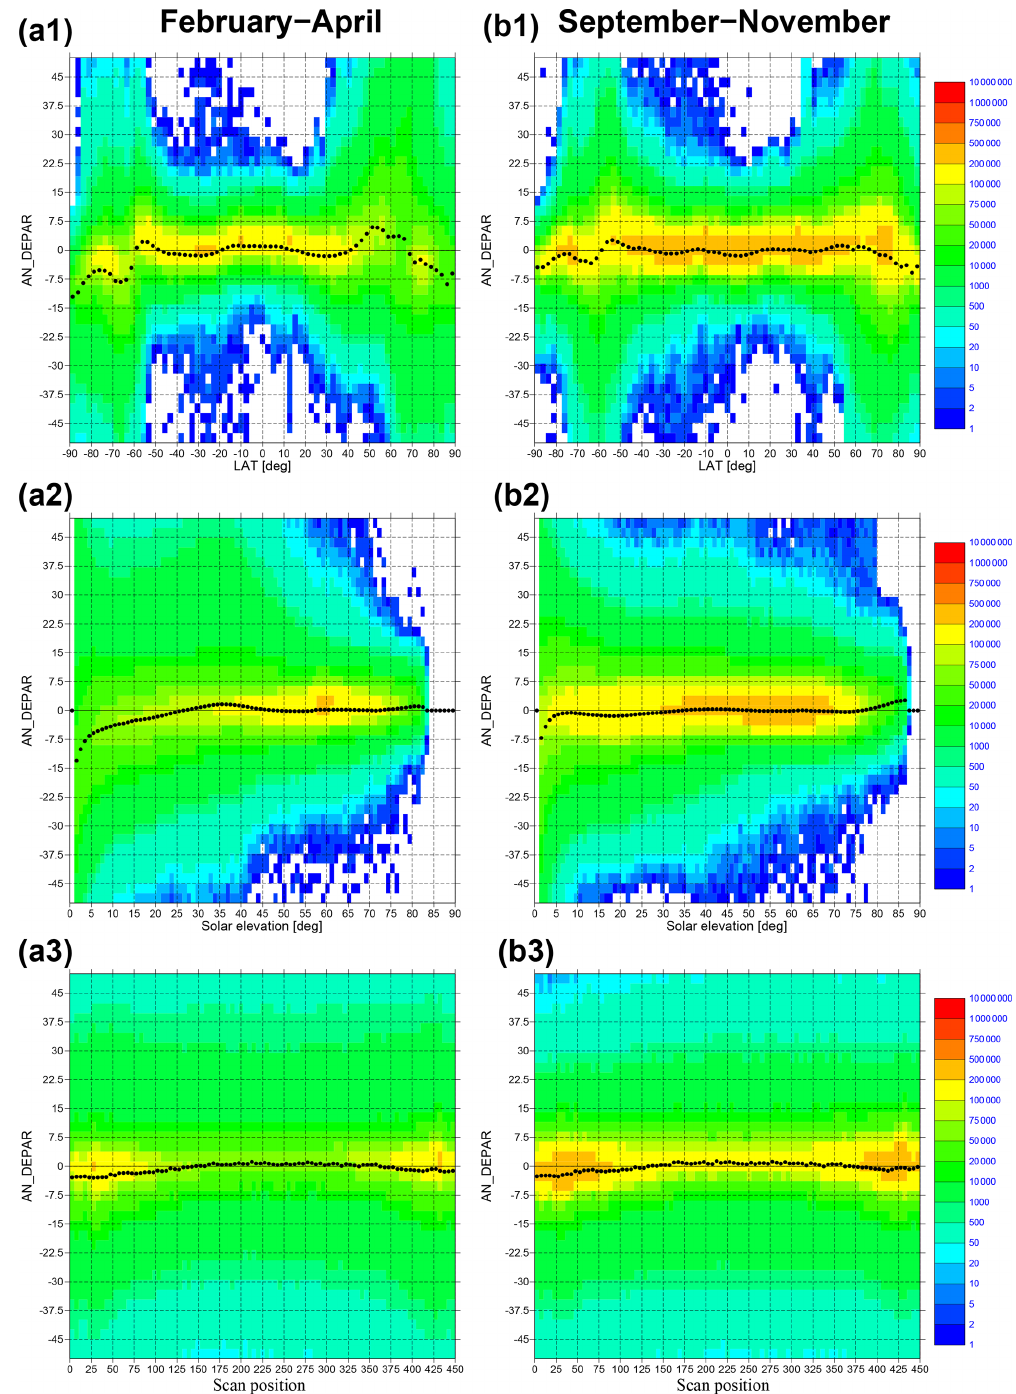
Figure 6. Scatter plots of good TROPOMI NRT TCO3 analysis departures for (1) latitude, (2) solar elevation and (3) scan position for (a) FMA 2018 and (b) SON 2018. Values are in